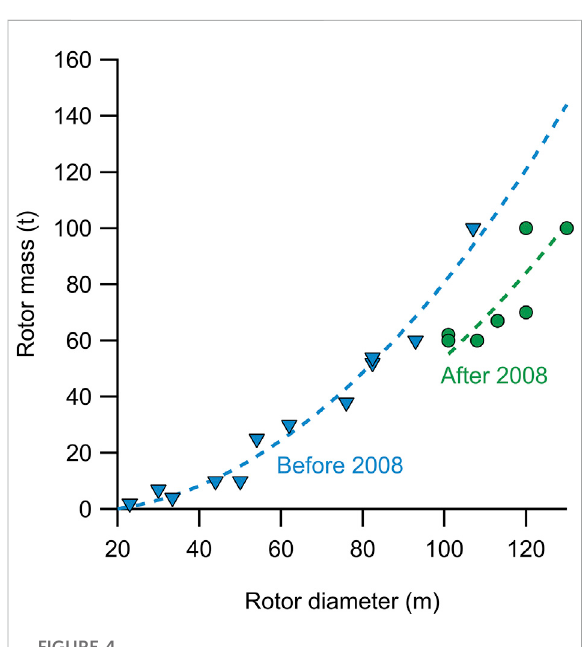
FIGURE 4 Rotor mass in tons vs rotor diameter in meters for Siemens wind turbine products with trend lines fi t before (blue triangles) and after (green circles) the adoption of bend-twist coupling and fl atback airfoils (2008). Signi fi cant reduction in scaling trends enables larger rotors and lower levelized cost of energy. Data source: (Thewindpower,